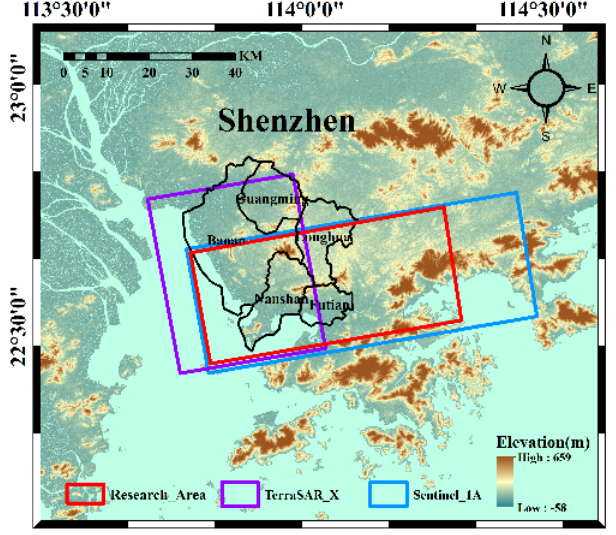
Figure 2. Location of the research area and frames of SAR datasets used in the study. The Shenzhen region was covered by a total of 81 Sentinel-1A recordings from March 2017 to April 2019 by the ascending satellite track number 11, and by 10 TerraSAR-X scenes with a spatial resolution of 3 m from August 2019 to May 2020 by the ascending track number 404. Both satellites traveled from approximately south to north at inclina- tions of 98.2° and 97.4°, respectively, and looked (and recorded) to the east during the ascending node. The orbit repeat cycle of the Sentinel-1A satellite was 12 days, while the repetition rate of the TerraSAR-X satellite was 11 days. An external DSM was used to re- move the influence of the terrain errors and DEM errors, in addition to refining computed InSAR PS geolocations in the subsequent differential interferometry. The basic SAR pa- rameters are given in Table 1. Tables 2 and 3 show the detailed parameters of the LiDAR and the DSM data of Shenzhen City. Table 1. Basic parameters of the used SAR satellite systems. Sensor TerraSAR-X 81 Table 2. Basic parameters of the used LiDAR data. Parameters Scan frequency (Hz)